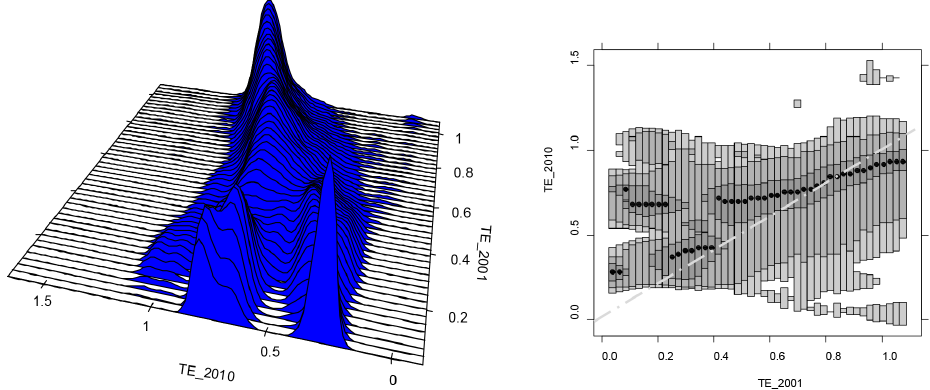
Fig. 2. Intra-distribution dynamics of technical efficiency for the period from 2001 to 2010 Note: Stacked density plot (left-hand side panel) and HDR plot (right-hand sidepanel) of highest conditional density for